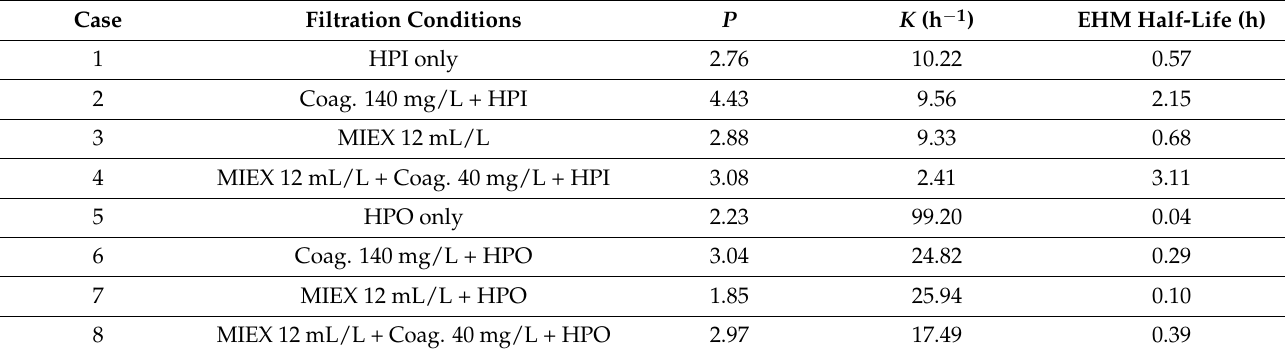
Table 2. EHM parameters for the regressions obtained in Example